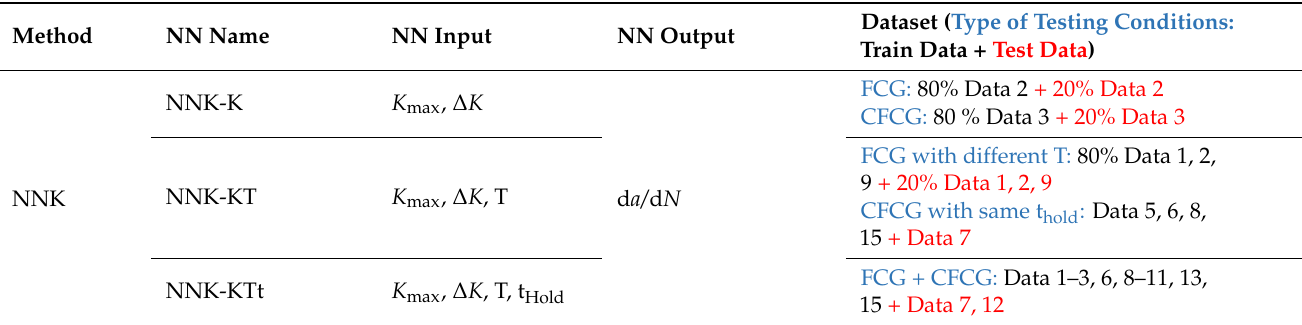
Table 4. List of modelling cases using NNK